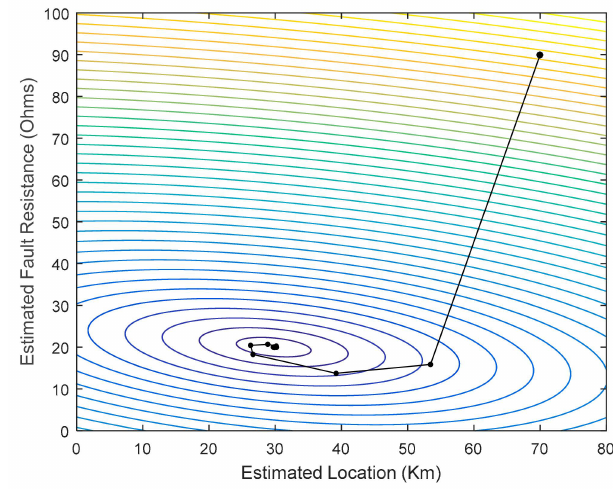
Figure 11. Fault location and resistance: